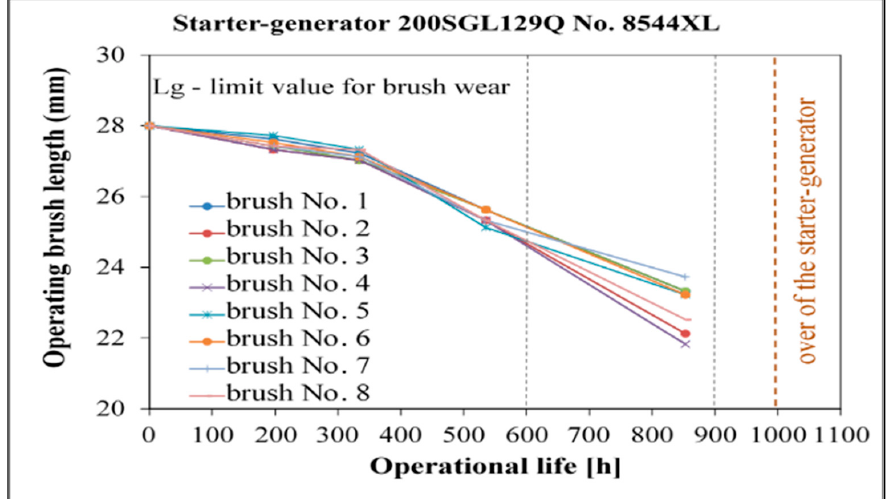
Figure 5. Relation between change in length of eight brushes of the 200SGL129Q starter-generator No. 8544XL.